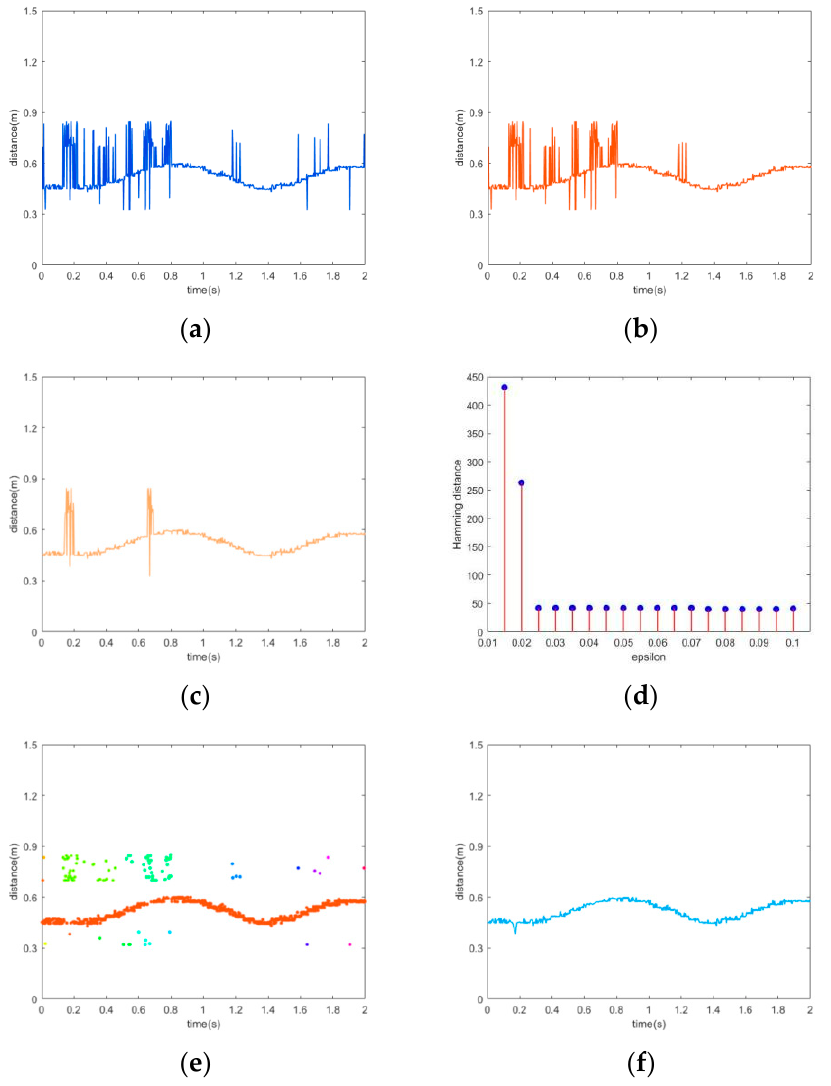
Figure 5. Smoothing results using different methods: ( a ) original sample series; ( b ) sliding mean filter; ( c ) sliding median filter; ( d ) Hamming distance; ( e ) DBSCAN with given EPS; ( f ) our proposed CDBSCAN.